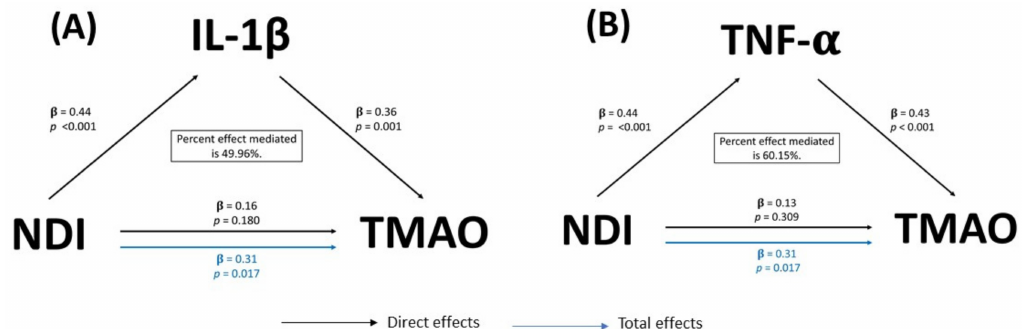
Figure 2. ( A ) Mediation model of the observed relationship between neighborhood deprivation index (NDI) and trimethylamine-N-oxide (TMAO) with IL-1 β as a mediator, model adjusted for ASCVD risk score and BMI, ( n = 59). ( B ) Mediation model of the observed relationship between neighborhood deprivation index (NDI) and trimethylamine-N- oxide (TMAO) with TNF- α as a mediator, model adjusted for ASCVD risk score and BMI ( n = 59). IL-1 β was undetectable in one individual ( n = 59). ASCVD risk score includes sex, age, race, total cholesterol, HDL-C, systolic blood pressure, personal history of diabetes, personal history of smoking, personal history of treatment for hypertension. ASCVD: atherosclerotic cardiovascular disease; BMI: body mass index; IL: interleukin; TNF: tumor necrosis